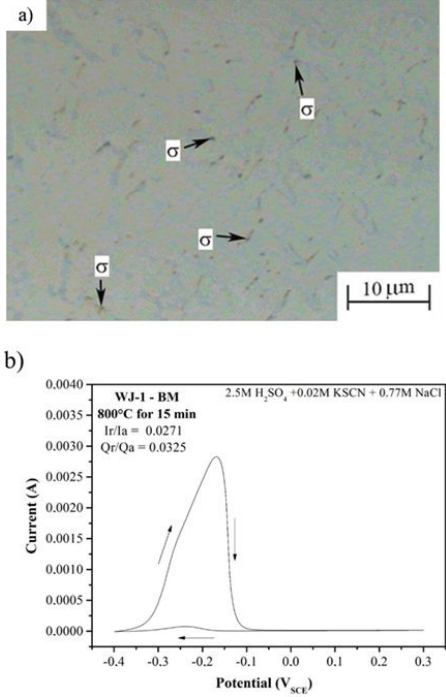
Figure 9. (a) Microstructures obtained by metallographic replica in BM of the WJ1-15 treated isothermally at 800°C for 15 minutes and (b) Ir/Ia values obtained by DL-EPR with solution containing 0.77M NaCl.